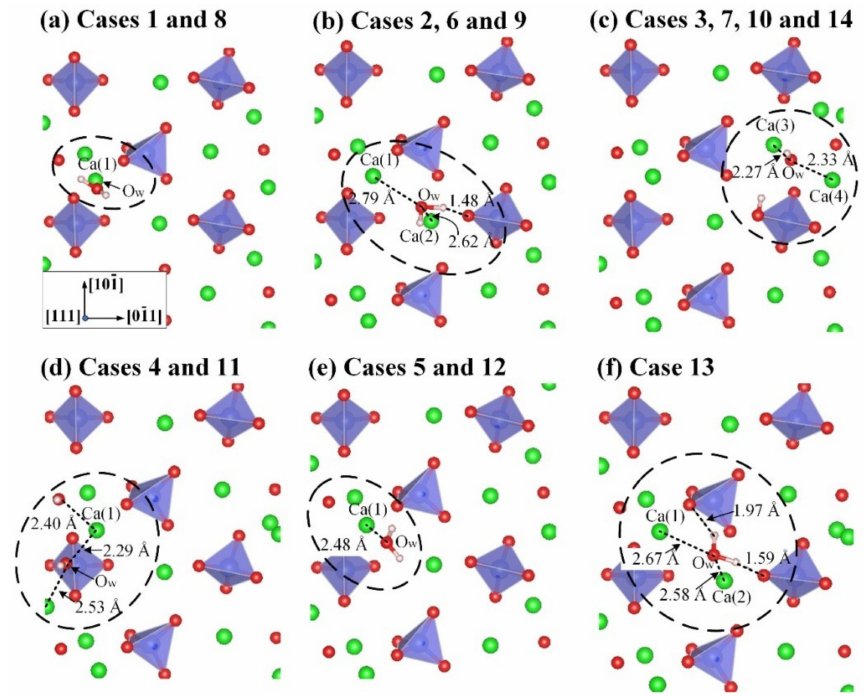
Figure A4. Top views of six adsorption configurations of a water molecule on the M3-C 3 S (111)